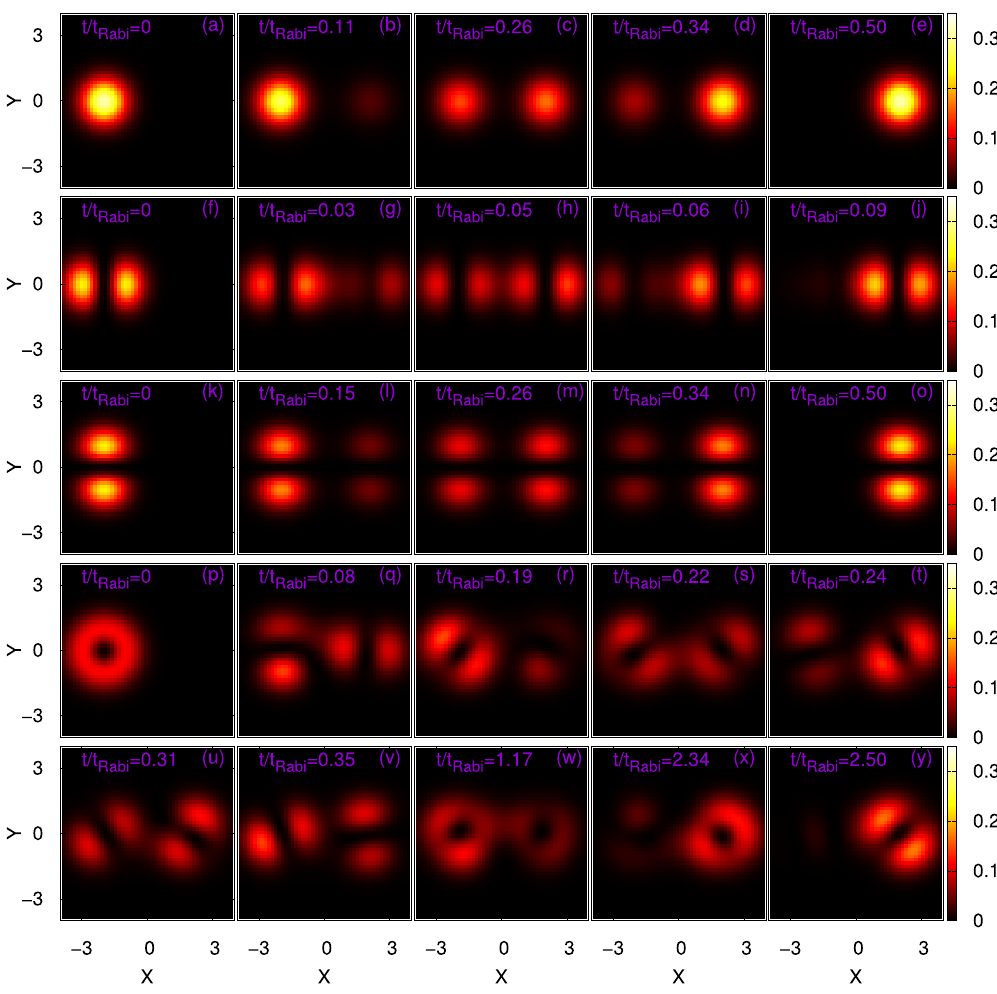
Figure 3. Time evolution of the many-body density oscillations in a symmetric 2D double-well. The 0.01 π and the number of bosons is N 10 . Shown are the densities per particle interaction parameter is � = = 0, 0.11, 0.26, 0.34 , and 0.50); (cid:31) for the initial states (cid:31) G (first row, from left to right, at t t X (second row, at Rabi = t t 0, 0.03, 0.05, 0.06 , and 0.09); (cid:31) 0, 0.15, 0.26, 0.34 , and 0.50); and (cid:31) V (fourth and Y (third row, at t Rabi = t Rabi = 0, 0.08, 0.19, 0.22, 0.24 and 0.31, 0.35, 1.17, 2.34, 2.50). The many-body time evolutions are fifth rows, at t t Rabi = 6 time-adaptive orbitals for (cid:31) 10 time- computed using the MCTDHB method with M G and (cid:31) X and M = = adaptive orbitals for (cid:31) Y and (cid:31) V . See the text for more details. The quantities shown are